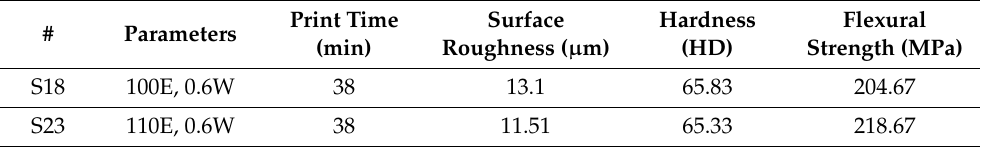
Figure 11. Three-axes plot for surface roughness, hardness, and flexural strength. Table 3. Description of optimal combinations (E = material extrusion rate; and W = line width).